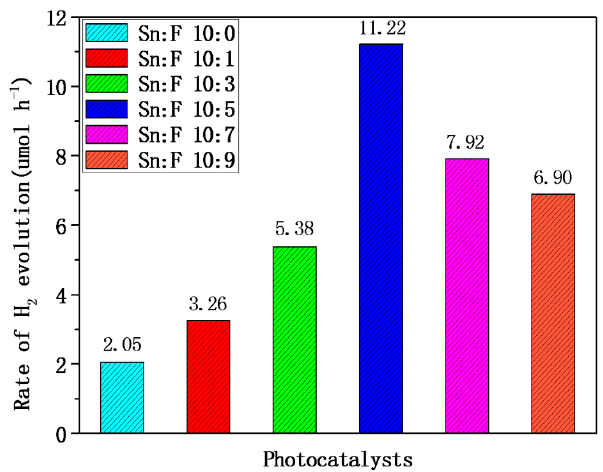
Figure 9. Photocatalytic H 2 evolution rates of 19.2% Cu/SnO 2 and 19.2% Cu/FTO samples with different Sn/F molar ratios under visible light irradiation.